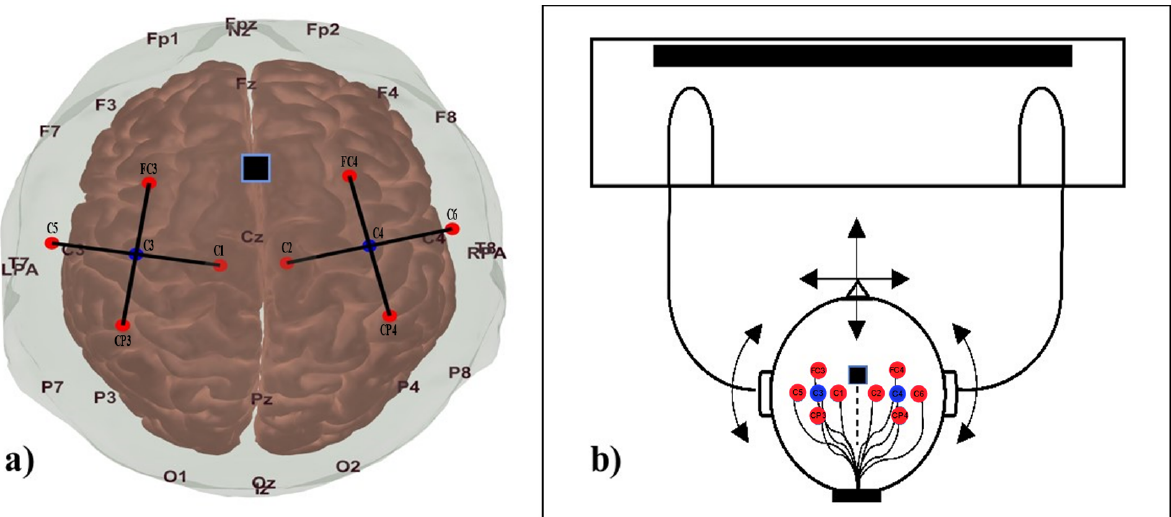
Figure 2. ( a ) Optode placement. We recorded using eight optodes placed according to the 10/20 system in positions approximately located over the hand area of the primary motor cortices. The two detectors placed at C3 and C4 are marked in blue, and the sources located at FC3, FC4, CP3, CP4, C1, C2, C5, and C5 are marked in red. The black lines approximate the channels. The accelerometer was located in the FCz position and is indicated by a black box. ( b ) The participant is seated in front of the monitor with his/her hands on the table. Arrows indicate the approximate directions of the head movements.